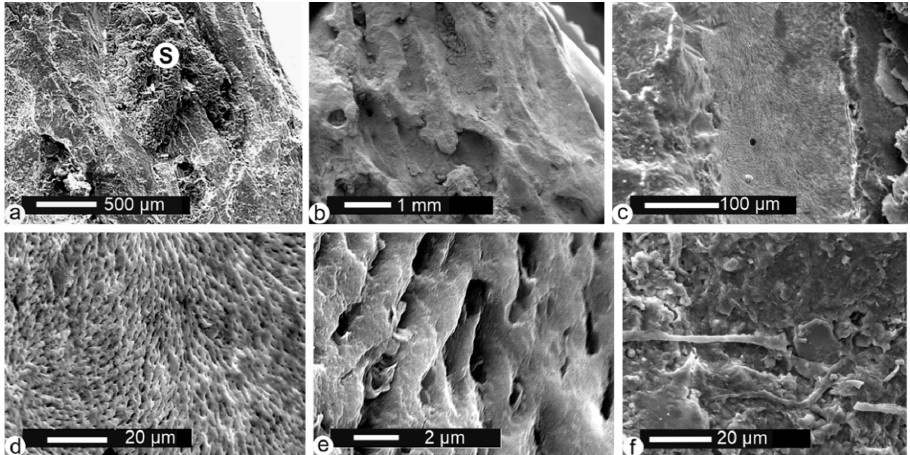
Figure 5. Fossil bones from Malema. ( a ) Secondary deposits on an etched surface of a long bone cleaned using an ultrasonic bath and H 2 O. ( b ) Alveolar structure of the same long bone. ( c ) Fracture showing the inner surface of a blood vessel. ( d , e ) Detail of Figure 5c, showing the preserved structure of the bone. ( f ) Organic filaments (fungi?) on the outer surface; sample cleaned using an ultrasonic bath and H 2 O. S: